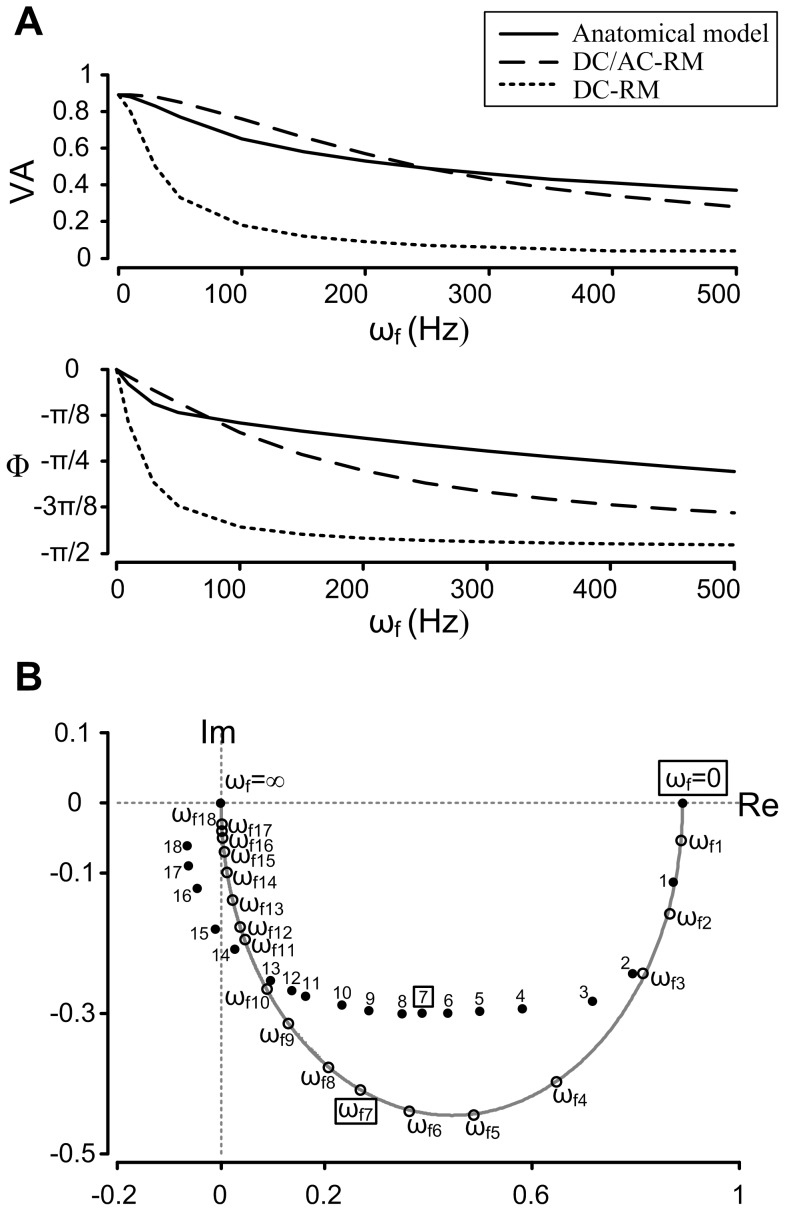
Comparison of the frequency response between the DC/AC-RM, DC-RM and anatomical motor neuron model.(A). Bode plots: amplitude (VA) and phase (Φ) response as a function of input signal frequency (ω). (B). Nyquist plot: integrated representation of frequency response in the complex domain consisting of Imaginary (Im) and Real (Re) axis. The frequency response of the DC/AC-RM is indicated by open circles and the grey line and anatomical model is by the filled circles. The positions of the individual data points were calculated for eighteen frequencies between ω = 0 to infinity: ωi = {10, 30, 50, 100, 150, 200, 250, 300, 400, 500, 700, 800, 1000, 1500, 2000, 3000, 4000, 5000}, where i = 1 to 18. The frequencies for the anatomical case were indicated only by i. The gray graph represents the frequency response of the DC/AC-RM for the continuous frequency vector. The frequencies for DC (ω = 0) and characteristic AC (ω7 = 250 Hz) signals are highlighted with squares.